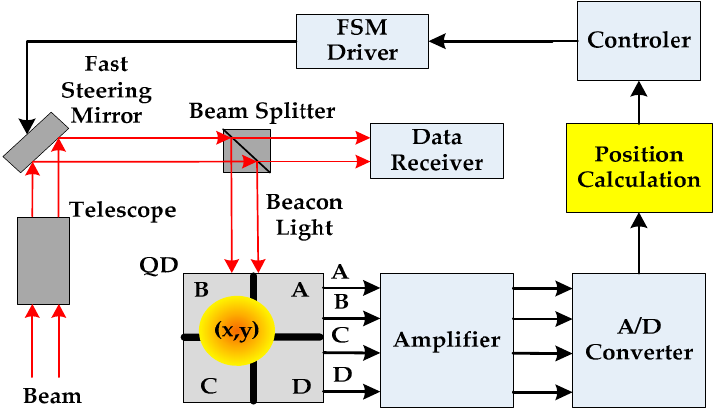
Figure 1. The telescope control system of the free space optical communication (FSO).